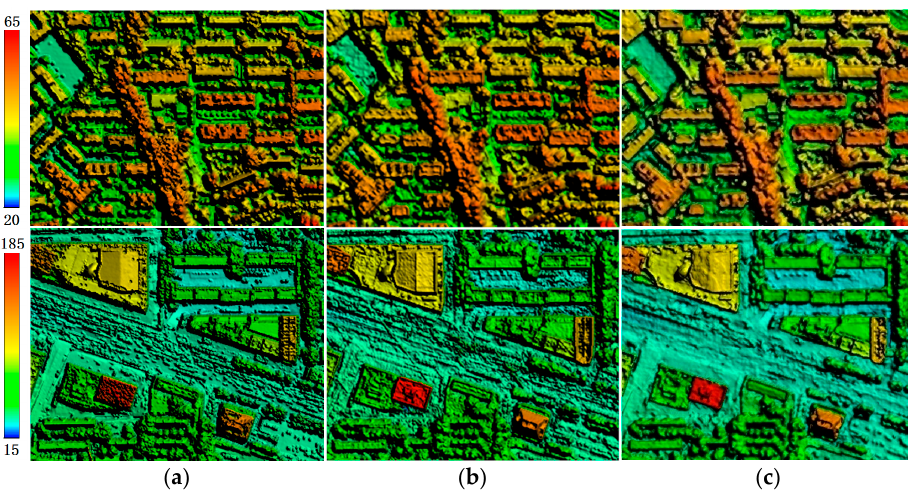
Figure 15. DSMs and subsets generated by LiDAR, SURE and the proposed SGVLL. The first row shows the entire DSMs and the other rows show the subsets picked from DSMs. DSMs generated: ( a ) LiDAR; ( b ) SURE; and ( c ) SGVLL.